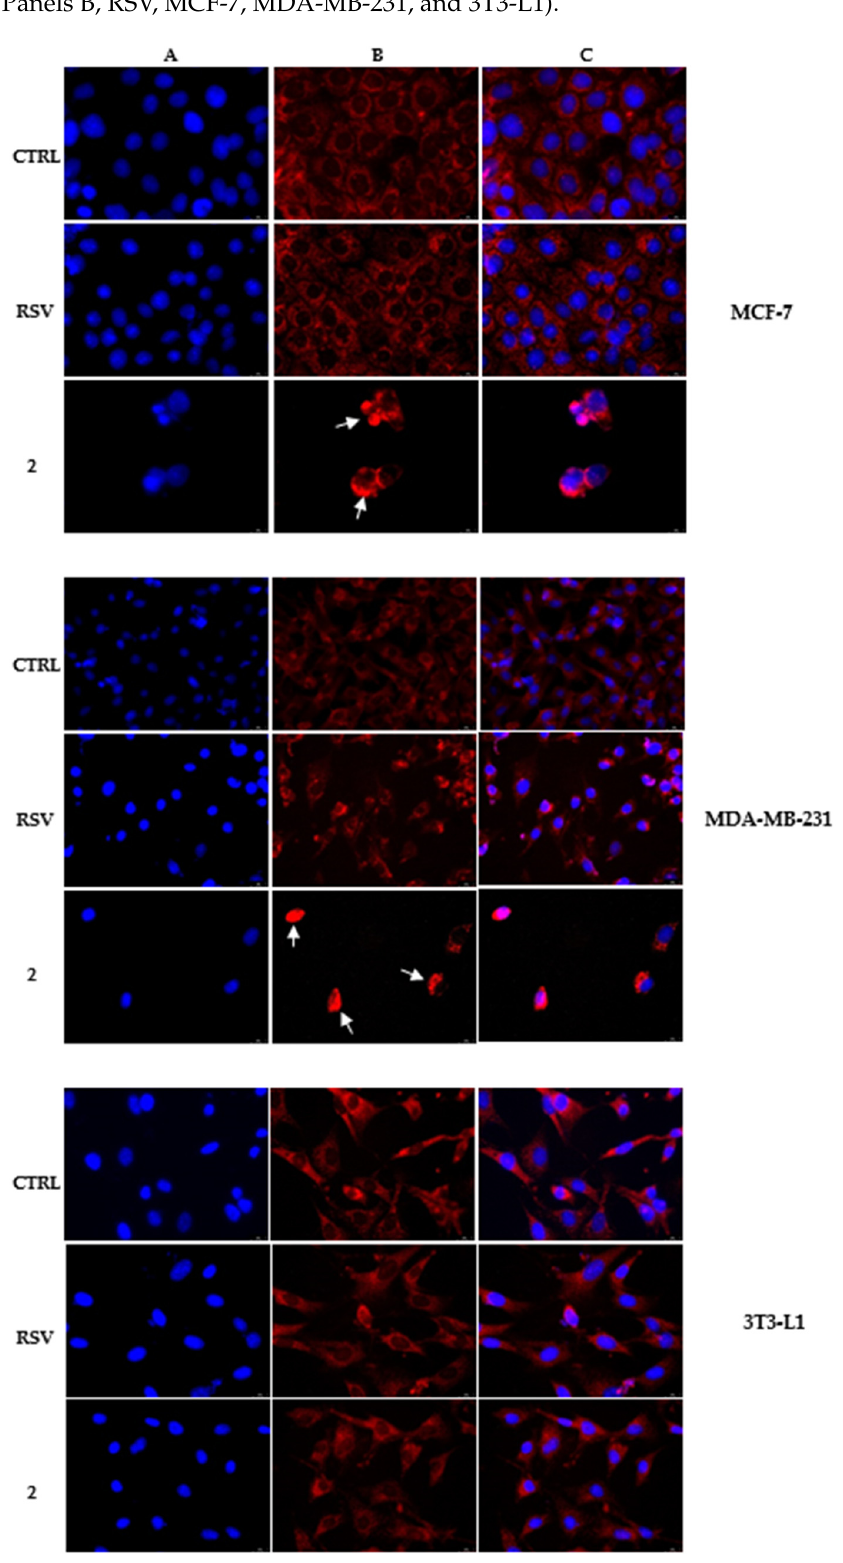
Figure 4. β -Tubulin immunofluorescence studies. MCF-7 and MDA-MB-231 breast cancer cells and 3T3-L1 cells treated with the derivative 2 (25 µM), RSV (25 µM), or with the vehicle (CTRL, DMSO) for 24 h, were incubated with a mouse anti- β -tubulin primary antibody and then with the mouse secondary antibody. CTRL cells and RSV-treated cells showed a regular cytoskeleton organization in all the cell lines used; 3T3-L1 cells treated with the derivative 2 also showed a normal arrangement of tubulin microtubules; contrarily, the derivative 2 induced a strong microtubules disorganization